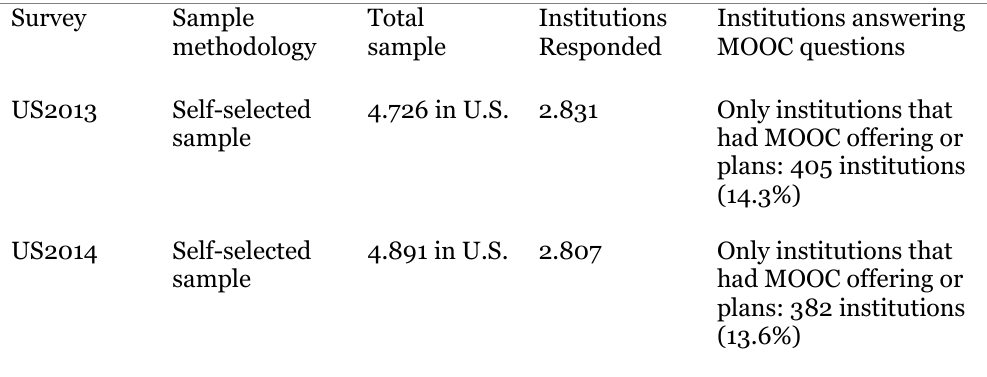
Survey Characteristics of Different MOOC Studies